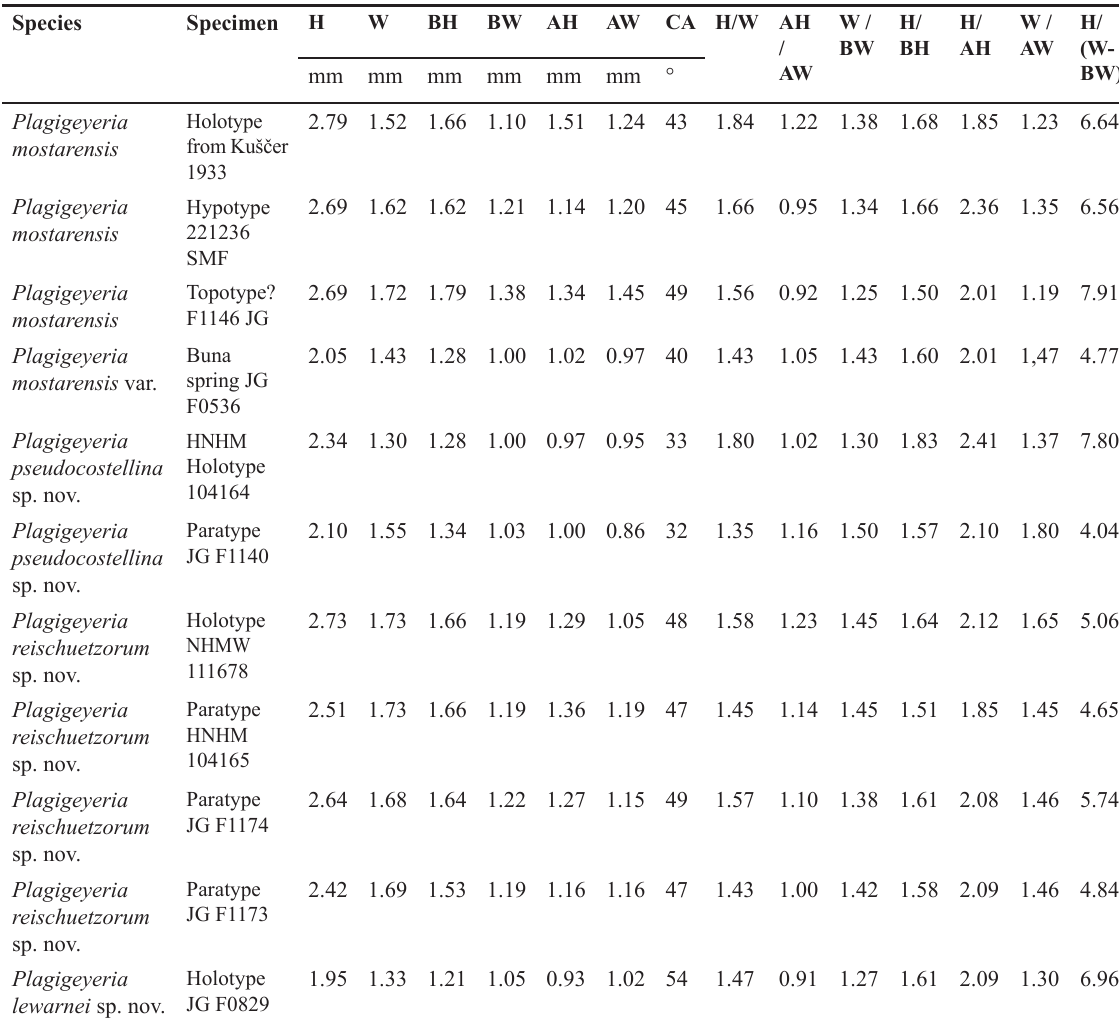
Table 1. Shell morphometry comparison of Plagigeyeria lewarnei sp. nov . , P. mostarensis Kuščer, 1933 , P. pseudocostellina sp. nov. and P. reischuetzorum sp.